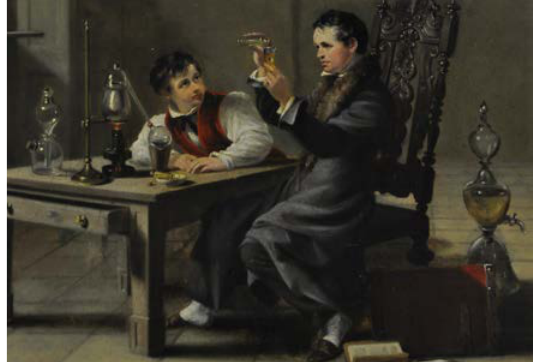
Figure 1. The painting “Chemist and Assistant in Laboratory” from 1827 depicts a teacher demon- strating the precipitation of Prussian blue to his student (source: Inv. 56577, © History of Science Museum, University of Oxford).